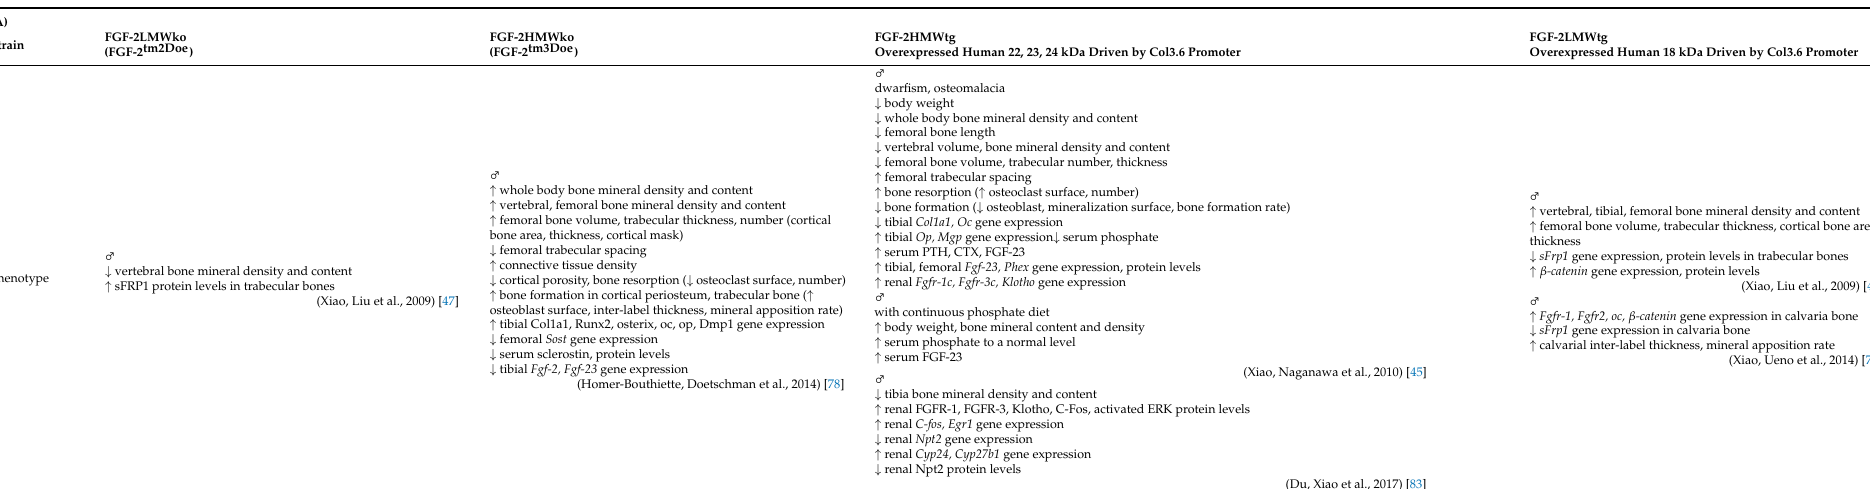
Osteoarthritis; Sox9, Sex-determining region Y box 9; Sost, sclerostin; tg, transgene; Vegf, vascular endothelial growth factor; Wnt,